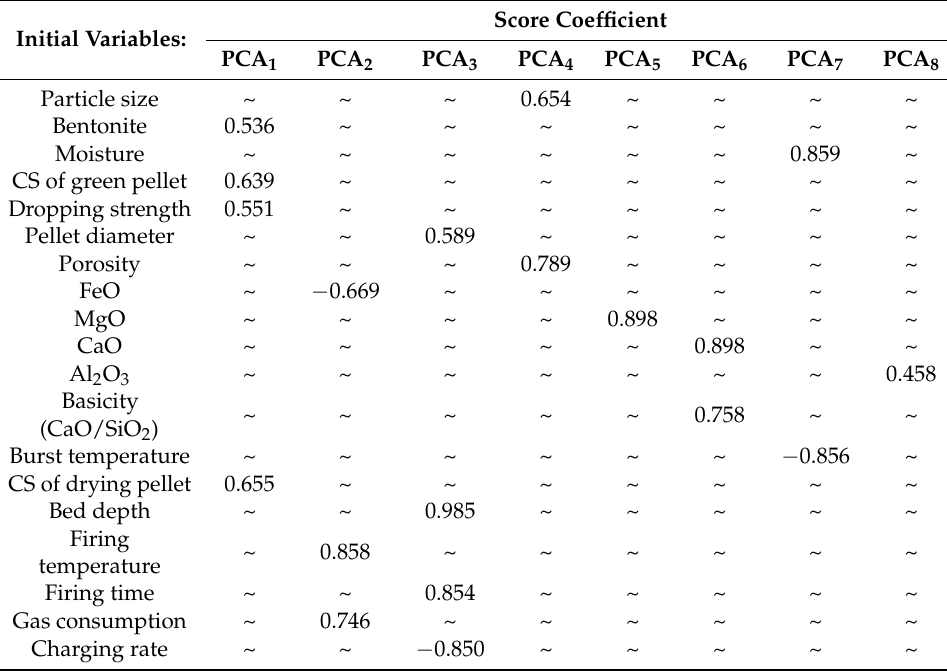
Table 4. Score coefficient between the PCA i ( i = 1~8) and initial